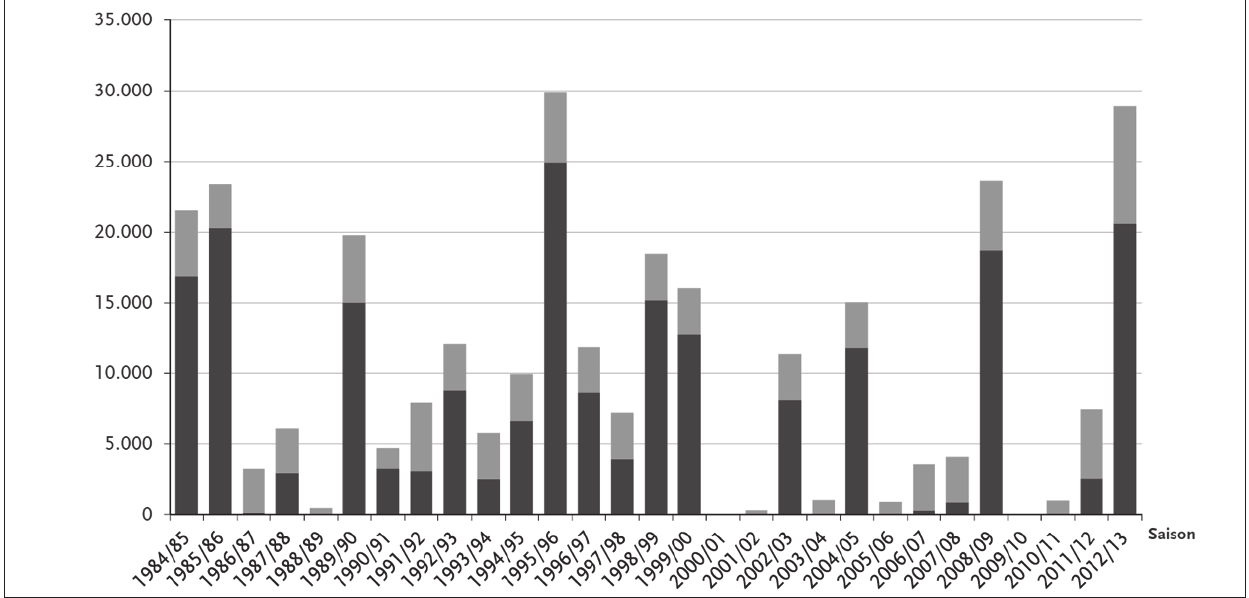
Fig. 1: Deaths attributed to influenza in Germany